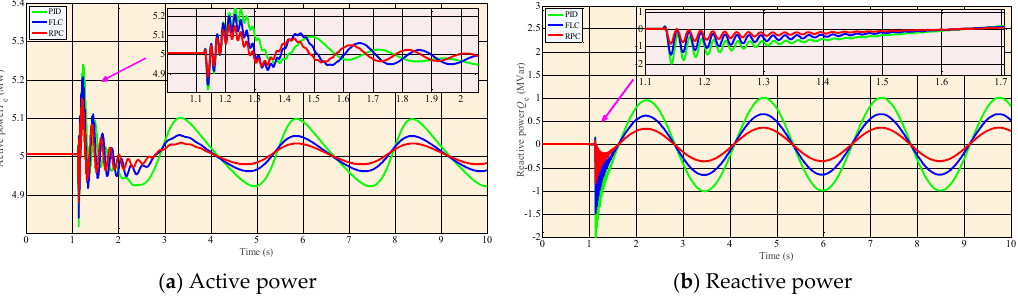
Figure 7. System responses obtained under an inter-area type disturbance v s = 1+ 0.1 sin ( π t /1.25).